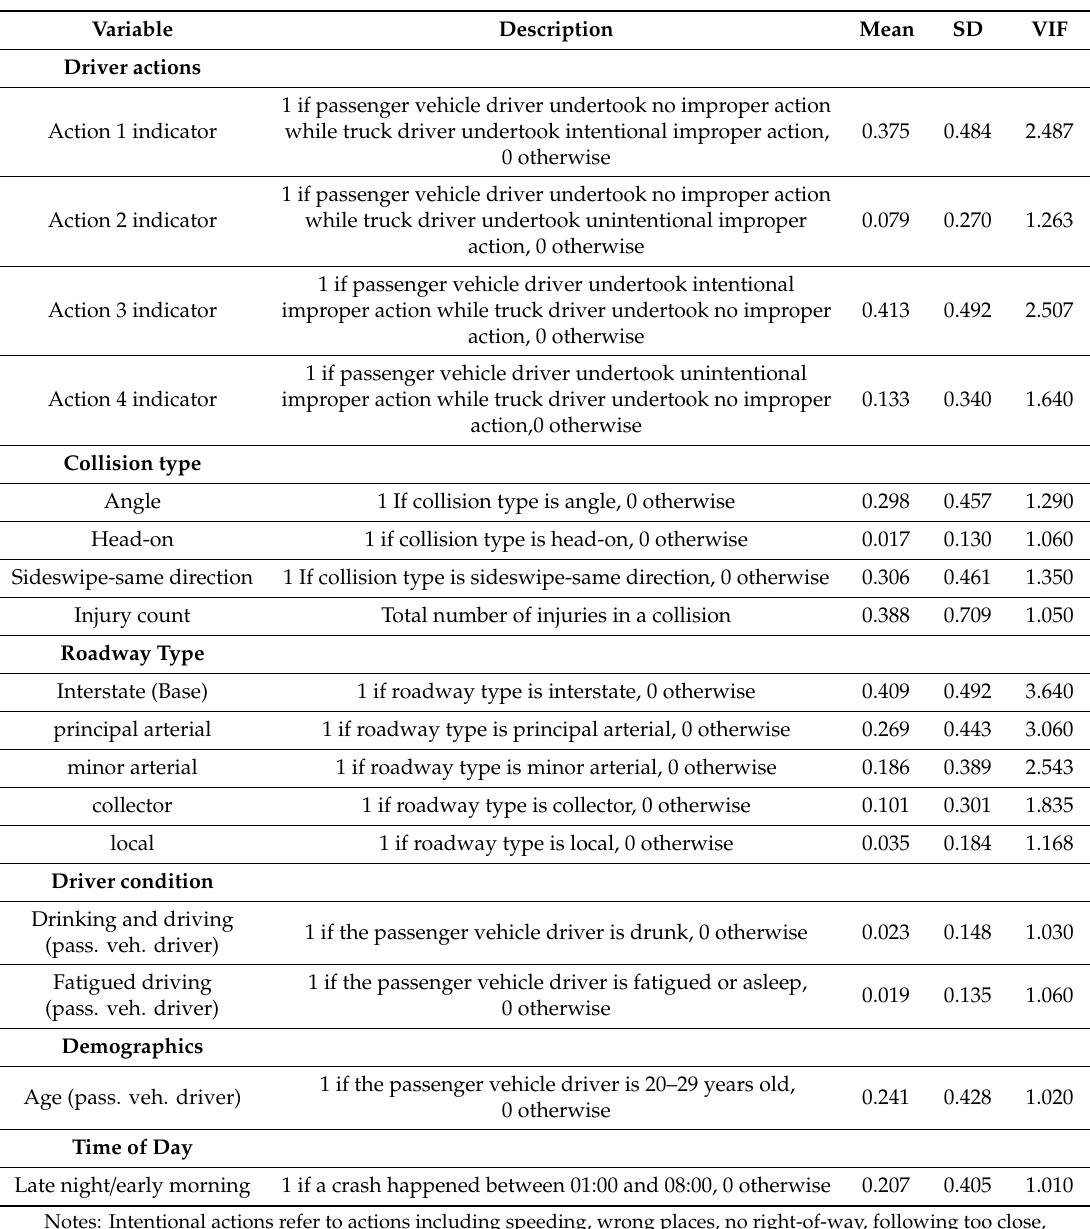
Table 2. Descriptive statistics of key